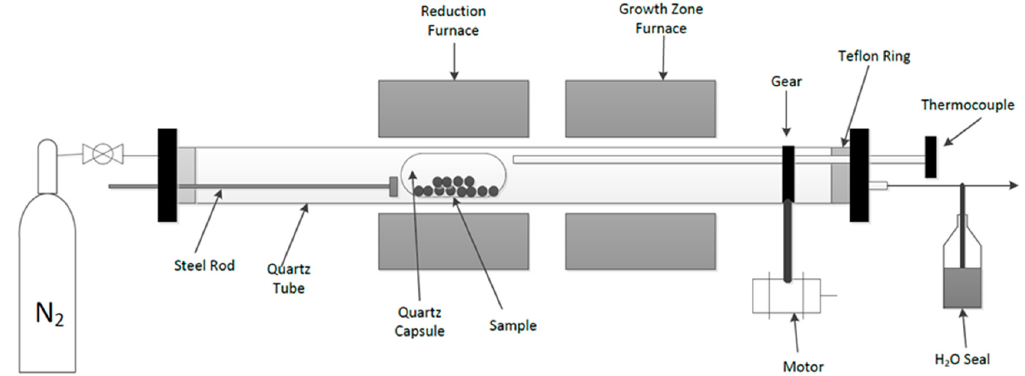
Figure 7. Schematic diagram of the rotary kiln.